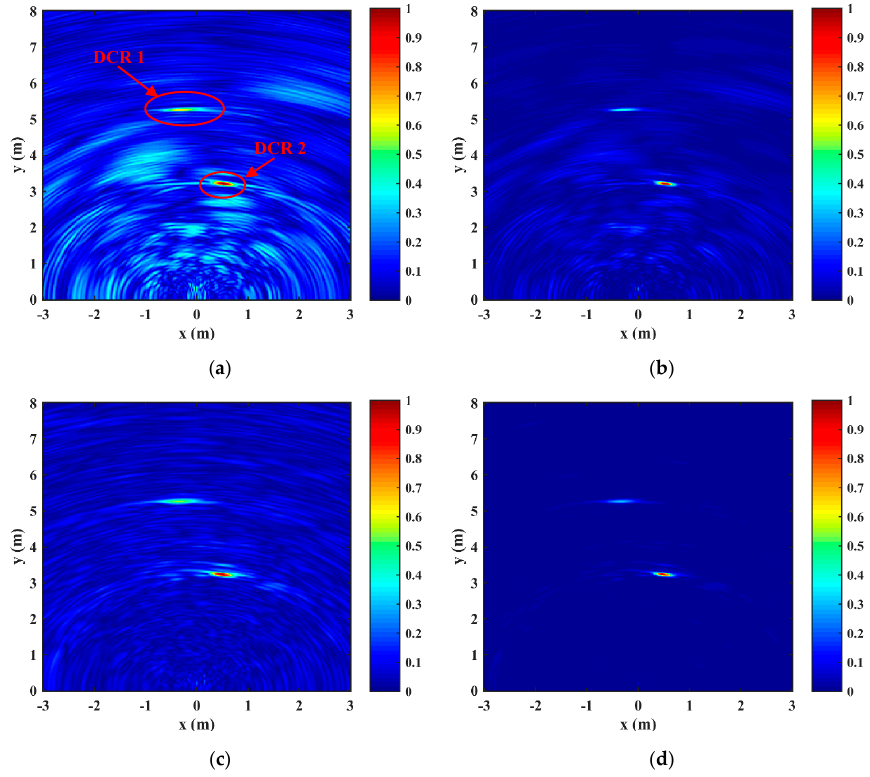
Figure 15. Imaging results of two corner reflectors by: ( a ) the TDBP algorithm with direct coupling removal; ( b ) the CC-TDBP algorithm with direct coupling removal; ( c ) the TDBP algorithm with background removal; ( d ) the CC-TDBP algorithm with background removal.